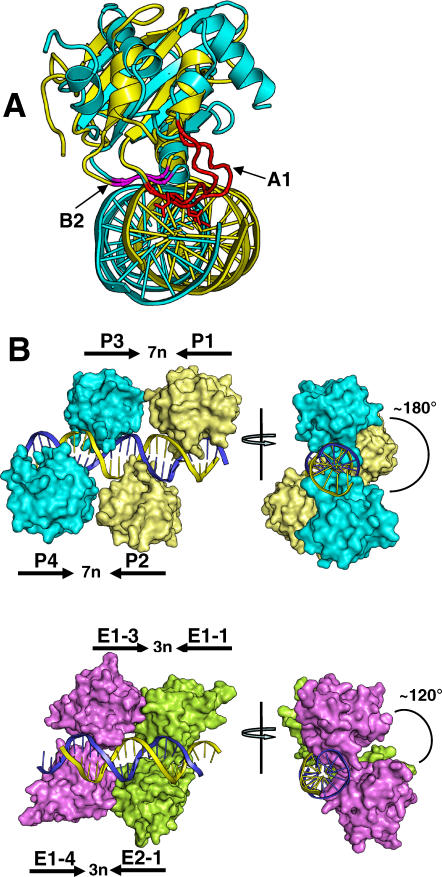
Comparison of T-ag obd and BPV E1 obd Co-Structures(A) The BPV E1 obd (cyan) was superimposed onto the T-ag obd (yellow). The molecules are displayed as ribbon diagrams looking down the helical axis of the DNA. The A1 and B2 loops (and their E1 equivalents) are shown in red and magenta, respectively. The residues that make most of the sequence-specific contacts in T-ag obd (Asn153 and Arg154) and the analogous E1 residues (Lys186 and Thr187) are shown as sticks. Part of the DNA in front of the A1 loop has been omitted from the figure. This view illustrates that even though the protein loops interacting with the DNA superimpose reasonably well, the DNA does not.(B) Comparison of the relative orientation of the SV40 and BPV obds bound to DNA. A model of four SV40 T-ag obds (yellow and cyan) engaged with the four GAGGC sites is shown. (Details of the construction of the model are in the legend for Figure 7.) The four BPV E1 obds (magenta and green) bound to the four E1 binding sites are shown below. The DNA is depicted as a ribbon diagram. The respective binding sites are labeled, and the number of nucleotides between the inverted repeats is shown. The T-ag obds do not interact, whereas the E1 obds form a dimer while bound to the inverted repeat E1–3 and E1–1 or E1–4 and E1–2. The T-ag obds bound to P1 and P2 (or P3 and P4) differ by approximately 180°, whereas the E1 obds bound to E1–1 and E1–2 (or E1–3 and E1–4) differ by approximately 120°. The two views, one looking down the helical axis of the DNA, illustrate the different spatial arrangement of the T-ag and E1 obds when bound to their respective ori sequences.